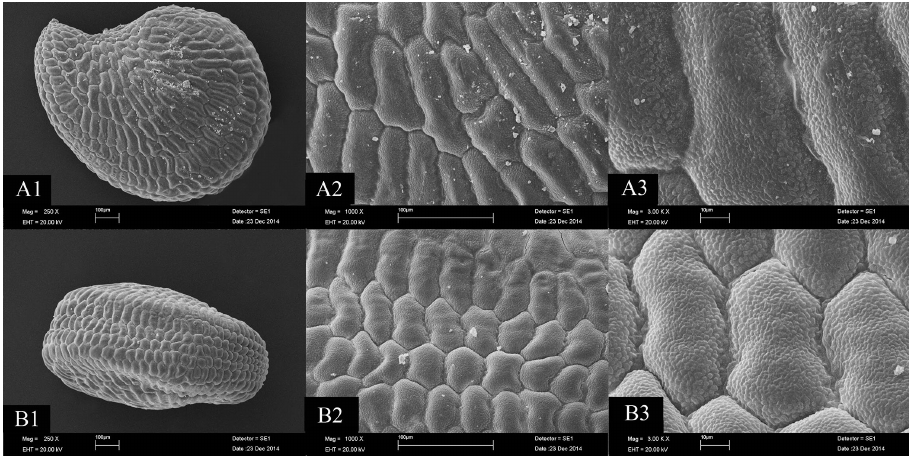
Figure 2. SEM photographs of the seed coat. Bolanthus turcicus – A1–3 ventral surface B1–3 dorsal surface (Scale bars 100